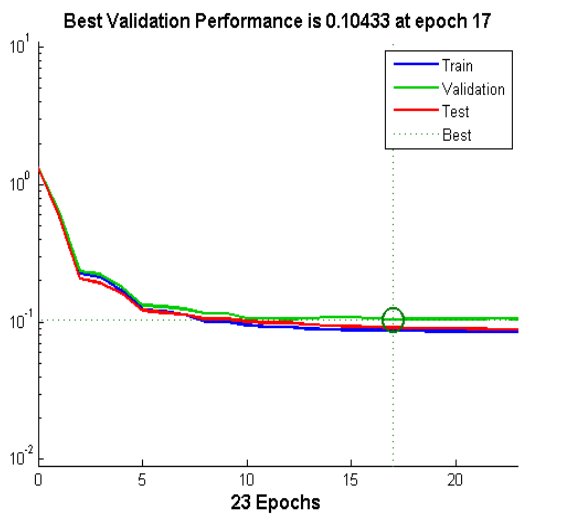
Figure 6. The convergence process of the NN network. After training the network all image objects were imported into the network and their situation were assessed. The final obtained change map is demonstrated in Figure 7.